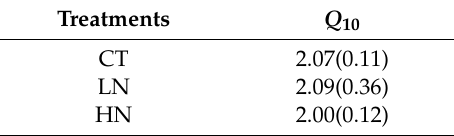
Figure 2. Annual cumulative soil respiration under di ff erent N treatments for the period of 2013–2015. * indicates statistically significant di ff erence at p < 0.05. Table 2. The soil respiration sensitivities to soil temperature for the period of 2013–2015.